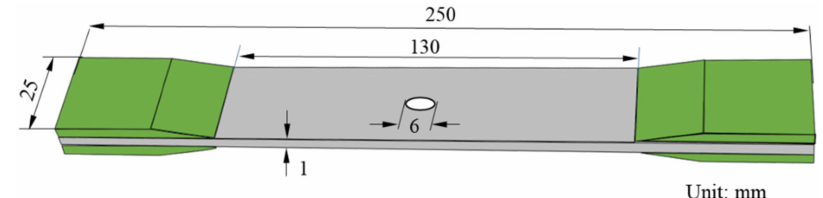
Figure 4. Specimen geometry.